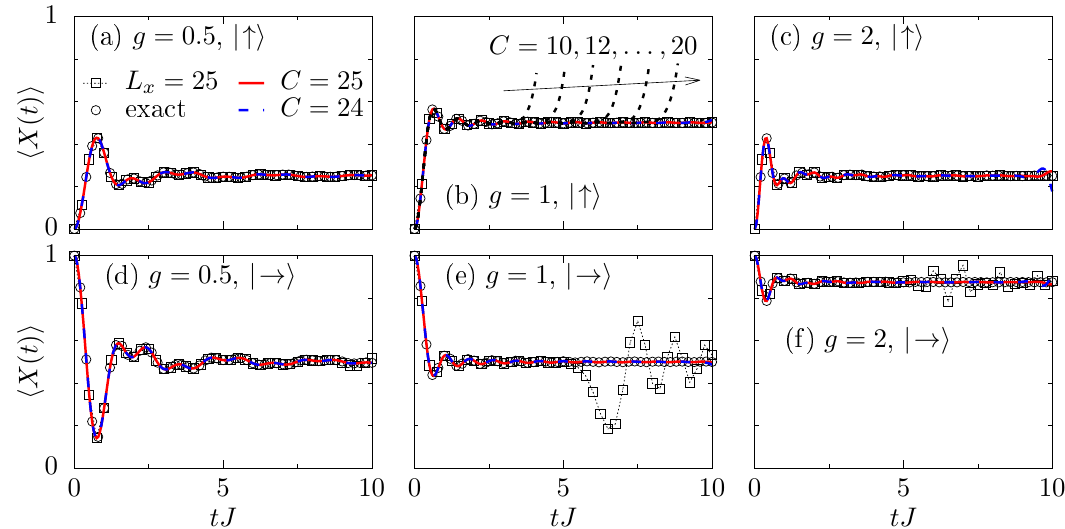
Figure 2: Dynamics of the transverse magnetization 〈 X ( t ) 〉 resulting from the initial state | ψ ( 0 ) 〉 = |↑〉 [ (a) - (c) ] , or | ψ ( 0 ) 〉 = |→〉 [ (d) - (f) ] , for chains with trans- verse fields g = 0.5,1,2. Numerical data obtained by NLCE for expansion orders C = 24,25 (blue and red curves) are compared to direct simulations for chains = 25 and PBC (open boxes), as well as to the exact, analytically known with L x result [ 86–88 ] given in Eq. (18) (open circles). In panel (b), we exemplarily show additional NLCE data for lower expansion orders C =